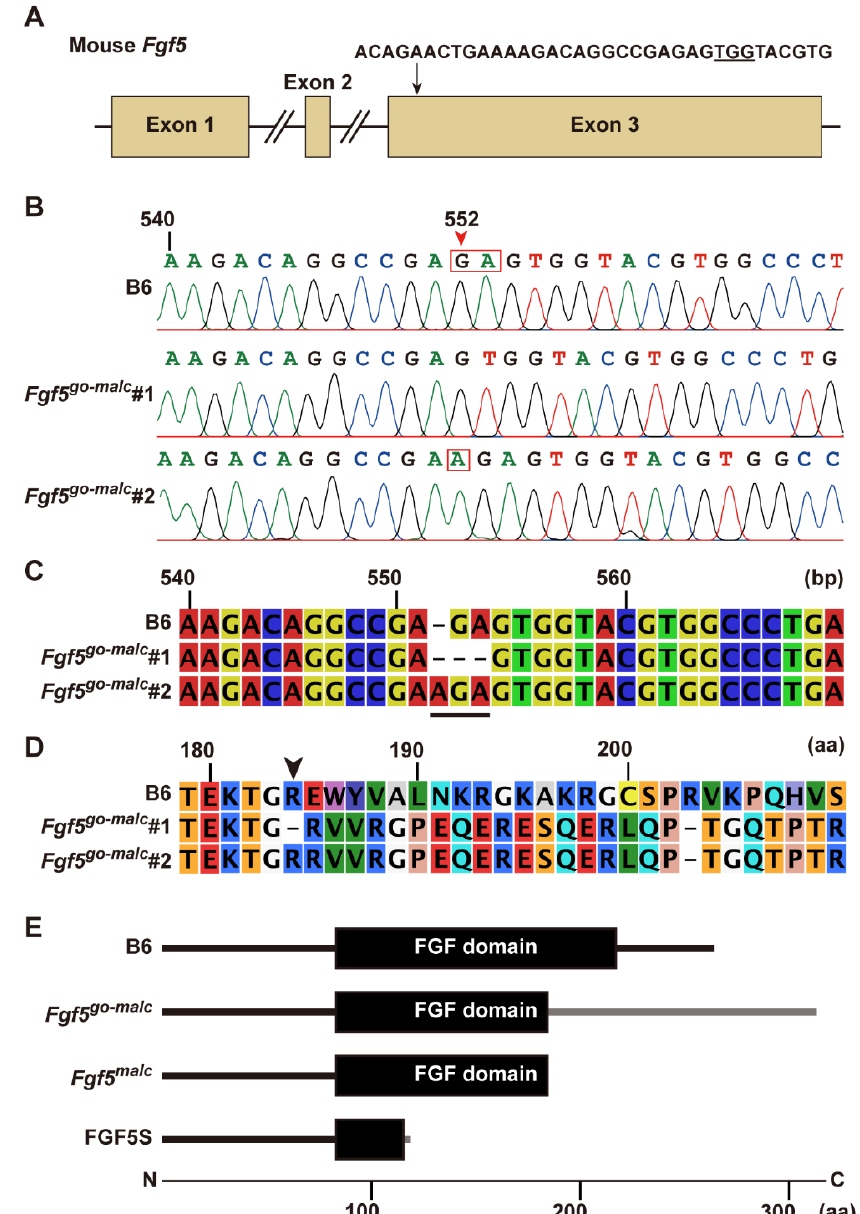
Figure 1. Characterization of mutations in Fgf5 go-malc mice. ( A ) Sequence of the synthesized guide RNA (gRNA). The arrow indicates the gRNA target site within exon 3 of the Fgf5 gene. The underlined sequence depicts the protospacer adjacent motif (PAM). ( B ) Electropherograms showing mutations in the two Fgf5 go-malc mouse lines ( Fgf5 go-malc1 and Fgf5 go-malc2 ). The red arrowhead indicates indels in the Fgf5 gene. A “GA” deletion and “A” insertion (red squares) were found in Fgf5 go-malc1 and Fgf5 go-malc2 mice, respectively. B6, C57BL/6J. ( C ) Alignment of the partial Fgf5 cDNA sequences in the B6, Fgf5 go-malc1 , and Fgf5 go-malc2 mice. The underlined region indicates the positions of the 2-bp